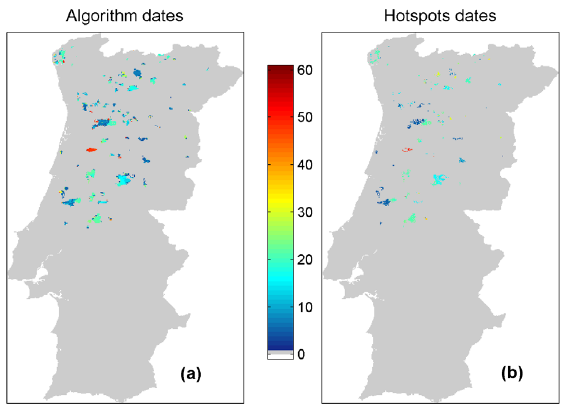
Figure 8 - Days of wildfires occurrences as obtained by the algorithm (a) and hotspots dates from MOD14 and MYD14 products (b) , for pixels that have been classified as burned by the two methods. Day 1 refers to August 1, and day 61, to September 30, 2005. Pixels in light gray represent unburned pixels and pixels in white correspond to pixels outside